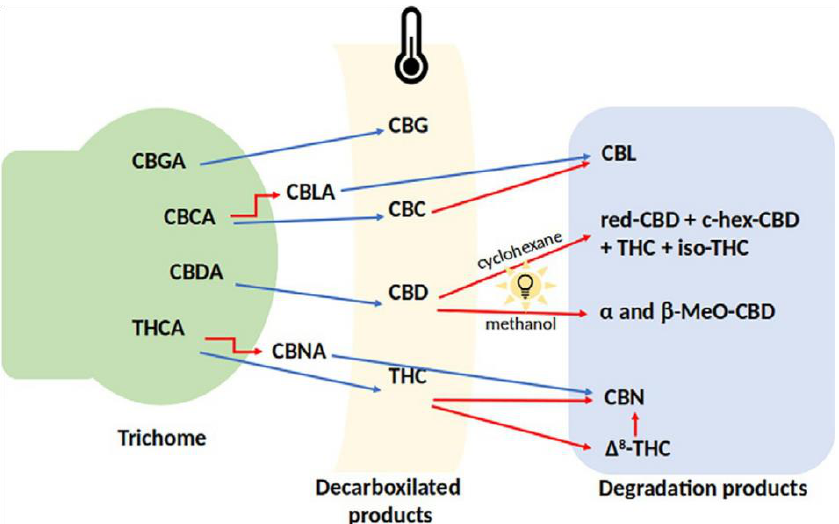
Figure 6. Hemp’s key components interconnected by decarboxylation. Adapted from Ramirez et al. [106], reprint permission had been obtained from Elsevier (Copyright 2019).